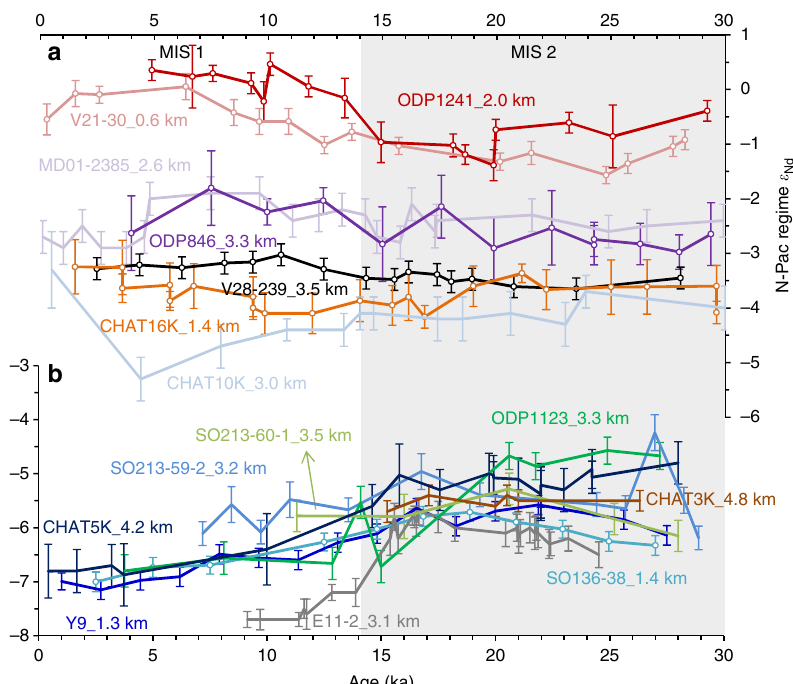
Fig. 5 A compilation of Paci fi c foraminiferal ε Nd records (0 – 30 ka). a N-Pac regime ε Nd patterns. b S-Pac regime ε Nd patterns. The records with open circle symbols are measured in this study. Data sources of the other records see Supplementary Table 1. The grey bar highlights the glacial stage MIS 2. Error bars show the 2 σ external error of the ε Nd measurements